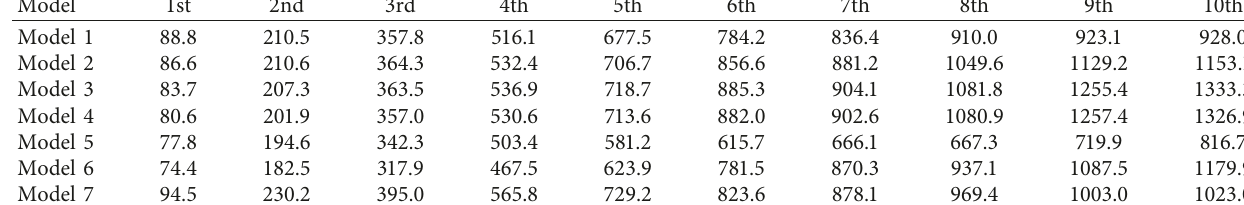
Table 1: Series of the natural frequencies of the representative uniform and gradient DAH sandwich models via SEM (Hz). Model